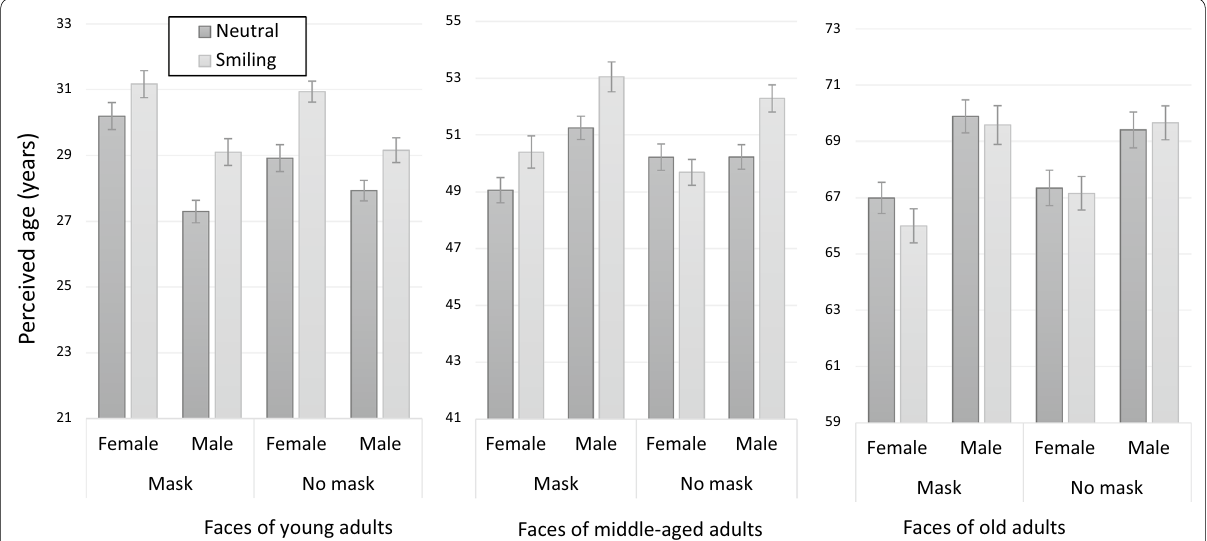
Fig. 3 The aging effect of smiling (AES) for masked and unmasked faces in Experiment 2. The results provide close replication of the results in Experiment 1. For masked faces, AES was found in young and middle-aged adults male and female photographs. Error bars represent standard errors of the